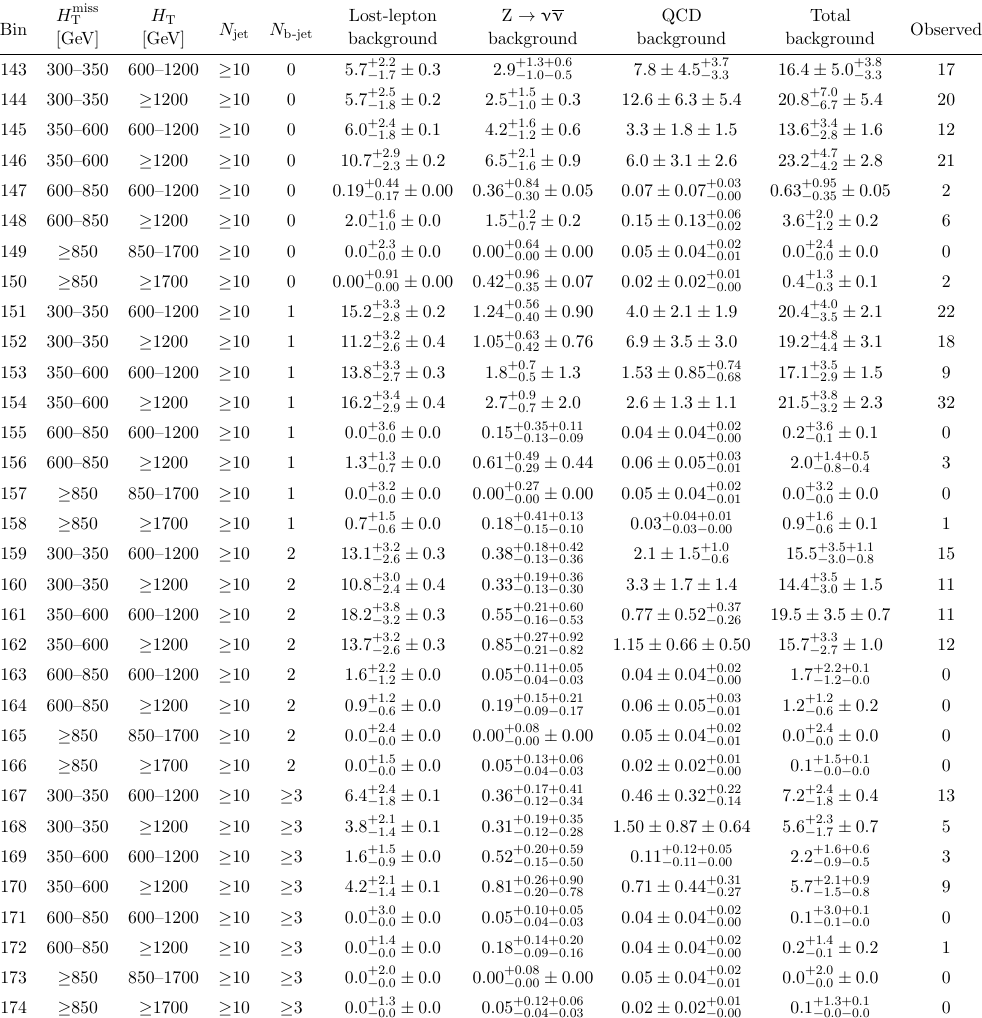
Table 7 . Observed number of events and pre-(cid:12)t background predictions in the N bins. For the background predictions, the (cid:12)rst uncertainty is statistical and the second